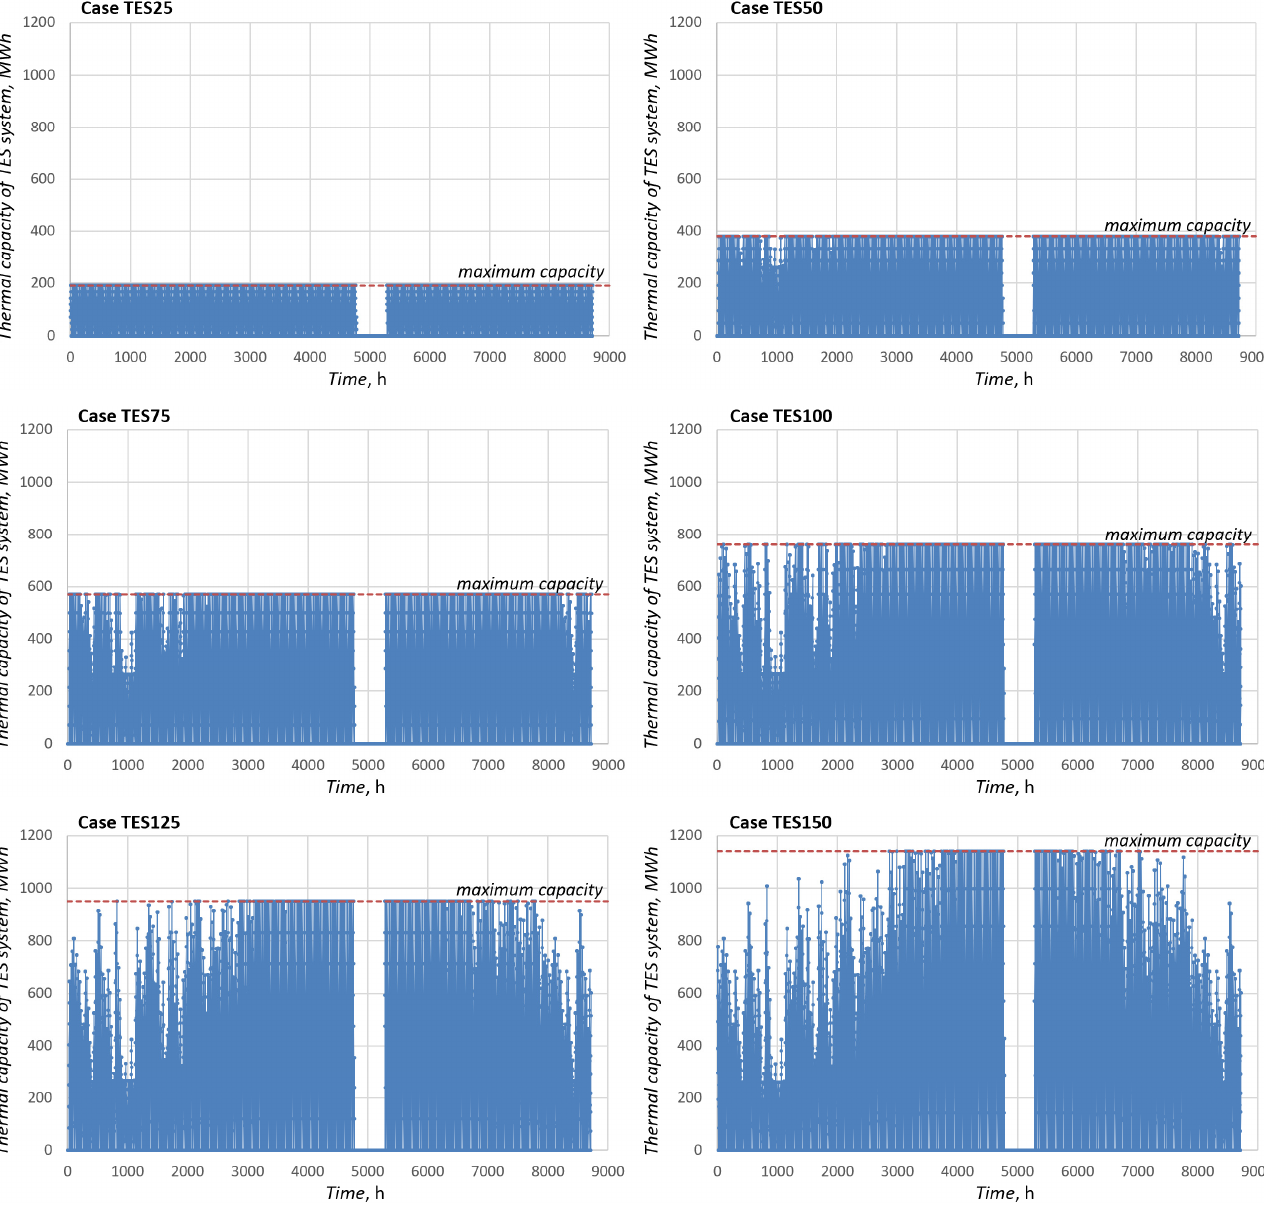
Figure 11. Thermal capacity of TES system as a function of time for reference year for all analyzed cases where TES is used.